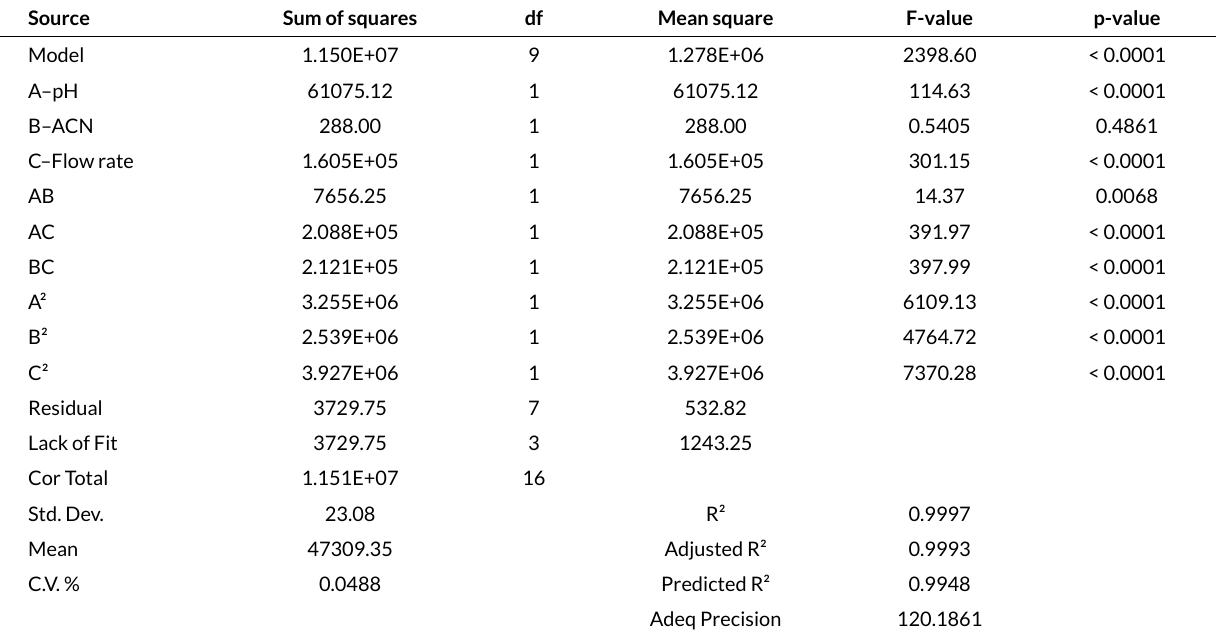
Table 5. ANOVA with peak area response in the contribution of parameters in the Quadratic model to determine acetic acid